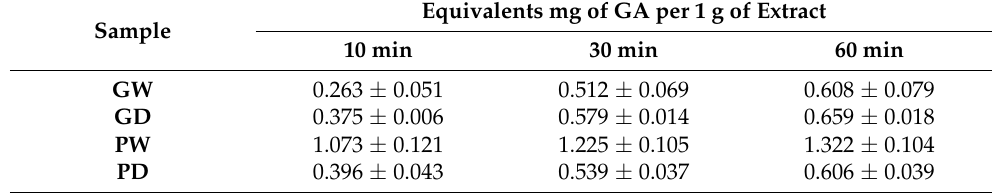
Table 3. Antioxidant power of the extracts expressed as equivalent GA mg ± SE at 10, 30 and 60 min per 1 g of extract ( n =